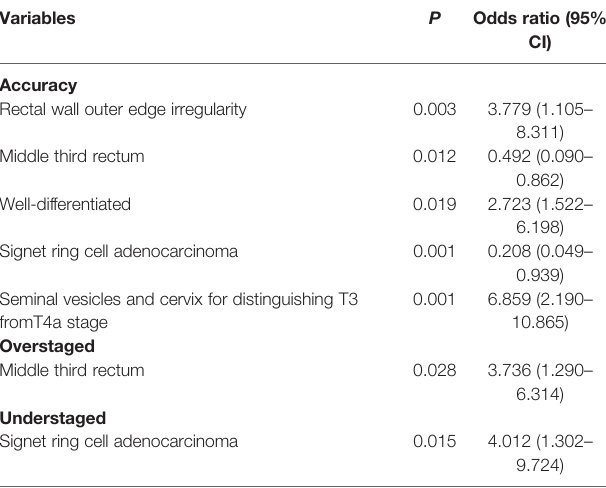
TABLE 5 | Multivariate analysis of clinicopathologic and endoscopic factors affecting EUS T staging.